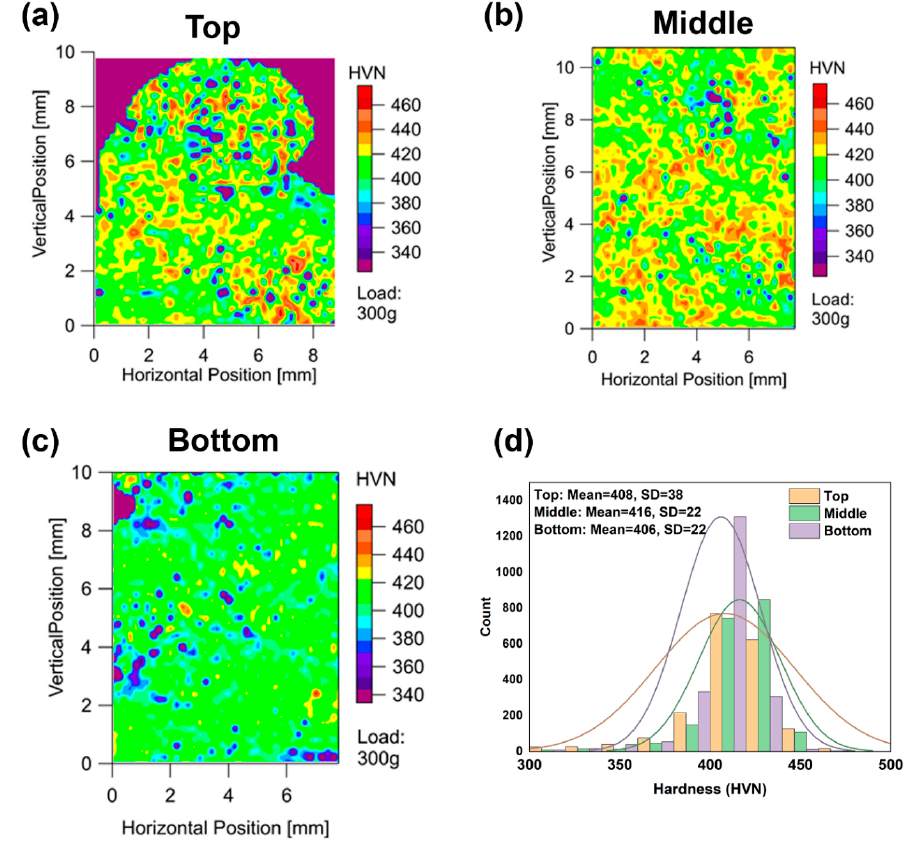
Figure 6. Hardness maps from different locations in the build height: ( a ) top; ( b ) middle; ( c ) bottom of the build. ( d ) Hardness distribution histogram of each region.